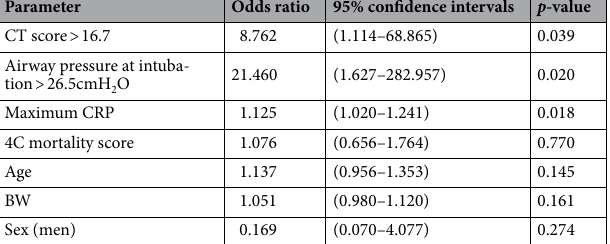
Table 4. Logistic analysis of clinical and CT features for COVID-19 pneumonia for death and ECMO. CT, computed tomography; CRP, C-reactive protein; BW, body weight; COVID-19, coronavirus disease 2019.